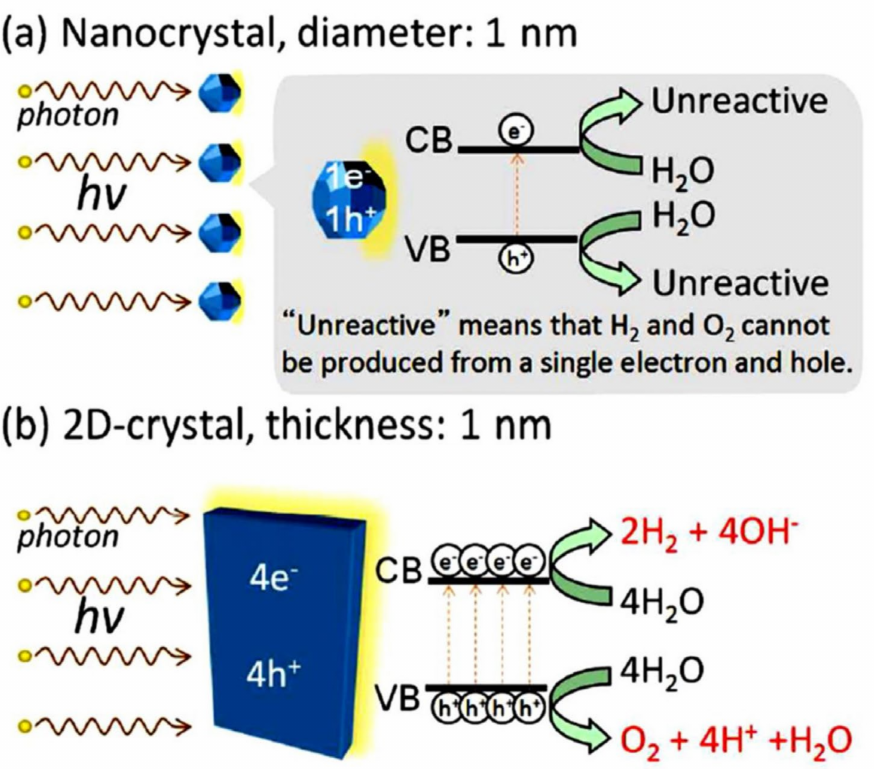
Figure 5. Schematic illustration of the photocatalytic water splitting reaction under solar light illumination for an ( a ) nanocrystal photocatalyst and ( b ) 2D photocatalyst. Adapted from [90] Copyright 2014, American Chemical